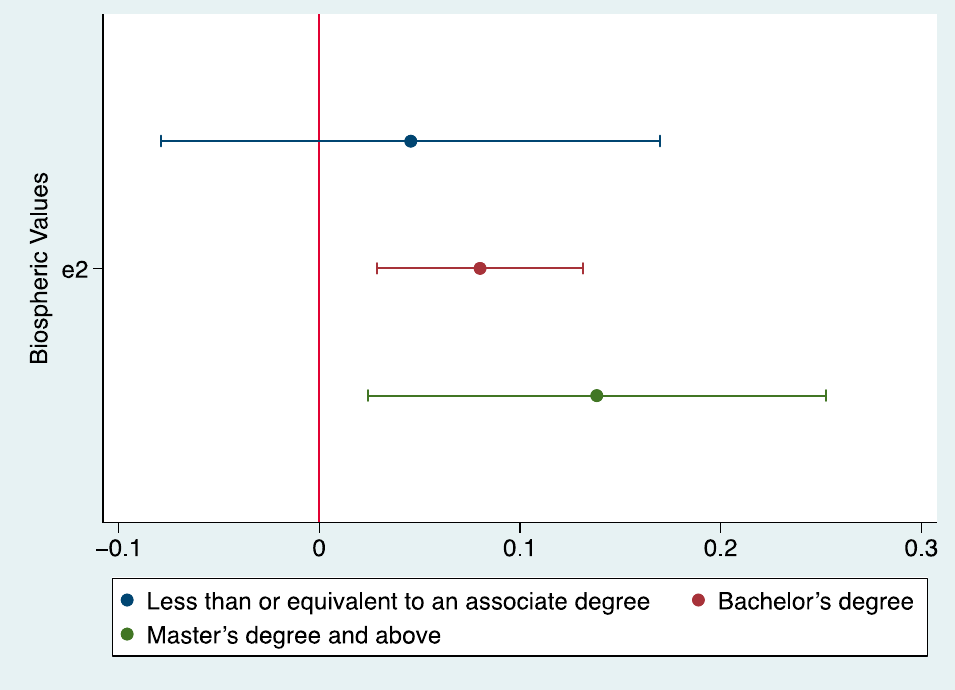
Figure 6. OLS coefficients of biospheric values on attitude by education, no covariates shown.